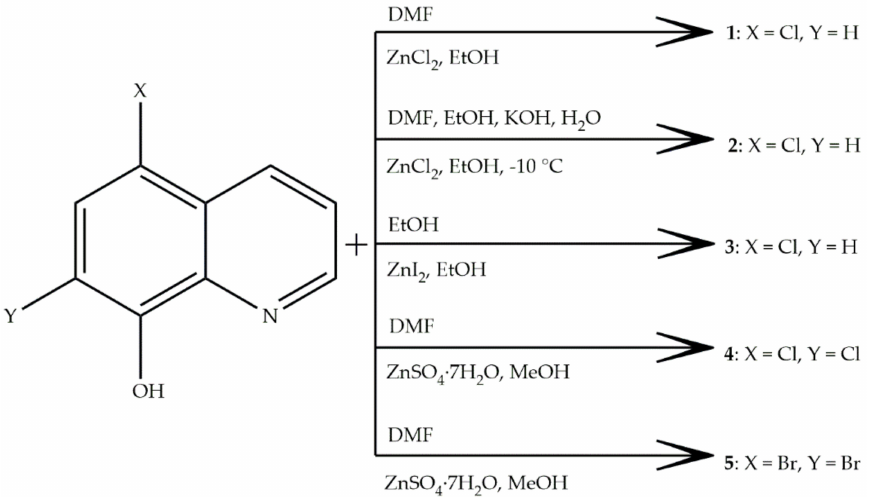
Figure 1. Synthesis and formulae of 1 – 5 . 1 : bis( µ 3 -5-chloro-8-hydroxyquinolinato)-tetrakis( µ 2 - 5-chloro-8-hydroxyquinolinato)-dichloride-tetra-zinc(II) bis-dimethylformamide solvate, [Zn 4 Cl 2 (ClQ) 6 ] · 2DMF; 2 : bis( µ 3 -5-chloro-8-hydroxyquinolinato)-tetrakis( µ 2 -5-chloro-8-hydroxyquinolinato)-diaqua- dichloride-tetra-zinc(II) tetra-dimethylformamide solvate, [Zn 4 Cl 2 (ClQ) 6 (H 2 O) 2 ] · 4DMF; 3 : tris(5-chloro-8-hydroxyquinolinato)-tris(5-chloro-8-hydroxyquinoline)-di-zinc(II) triiodide, [Zn